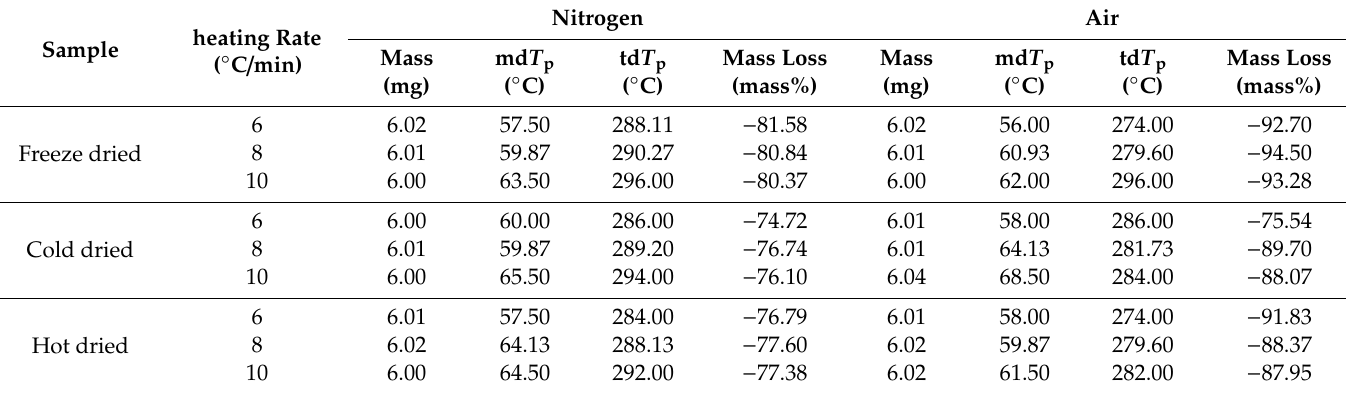
Table 4. Results of thermogravimetry (TGA) analyses for various drying processes from 30 to 500 ◦ C with multiple heating rates of 6, 8, and 10 ◦ C / min.